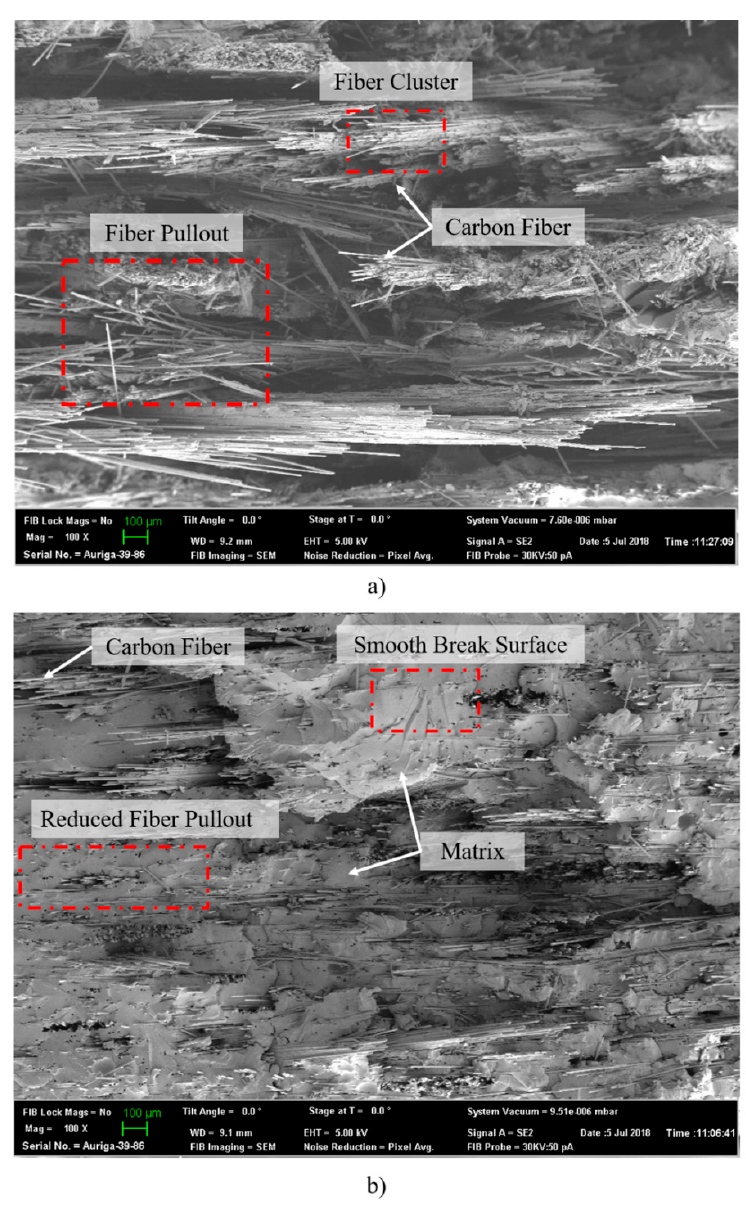
Figure 12. SEM images for selected break surface showing fiber random orientation and dispersion level for; ( a ) Method 1 sample break surface showing high density of bundle fibers, a sign of non-optimal dispersion, and ( b ) Method 2 sample break surface showing a clean area, a sign of optimal fiber dispersion. Table 4. Experimental flexural results for the CF / Epoxy plates produced with WL-CF mats from Method 1 and Method 2 of nonwoven